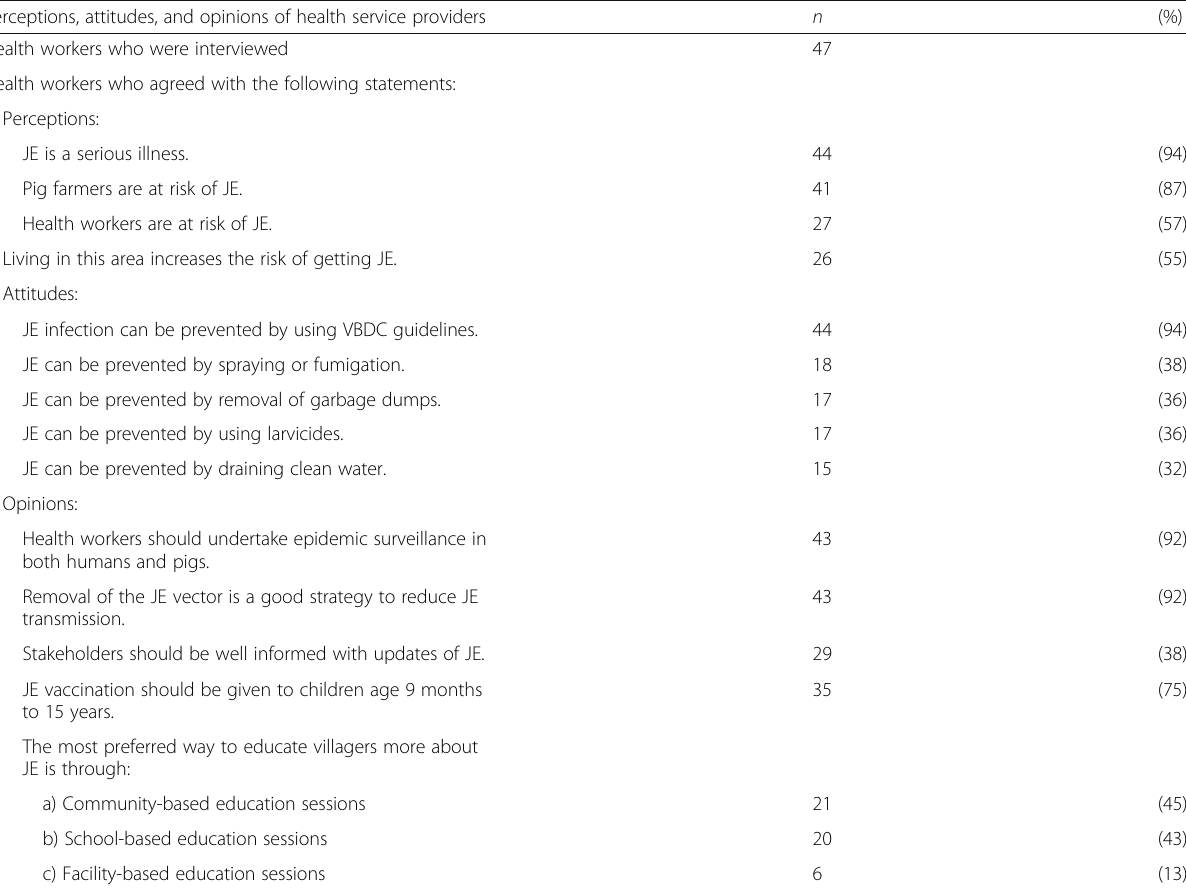
Table 5 Health service providers ’ perceptions, attitudes, and opinions about JE infection and its prevention in Letpadan Township, Bago Region, Myanmar, in January 2018 Perceptions, attitudes, and opinions of health service